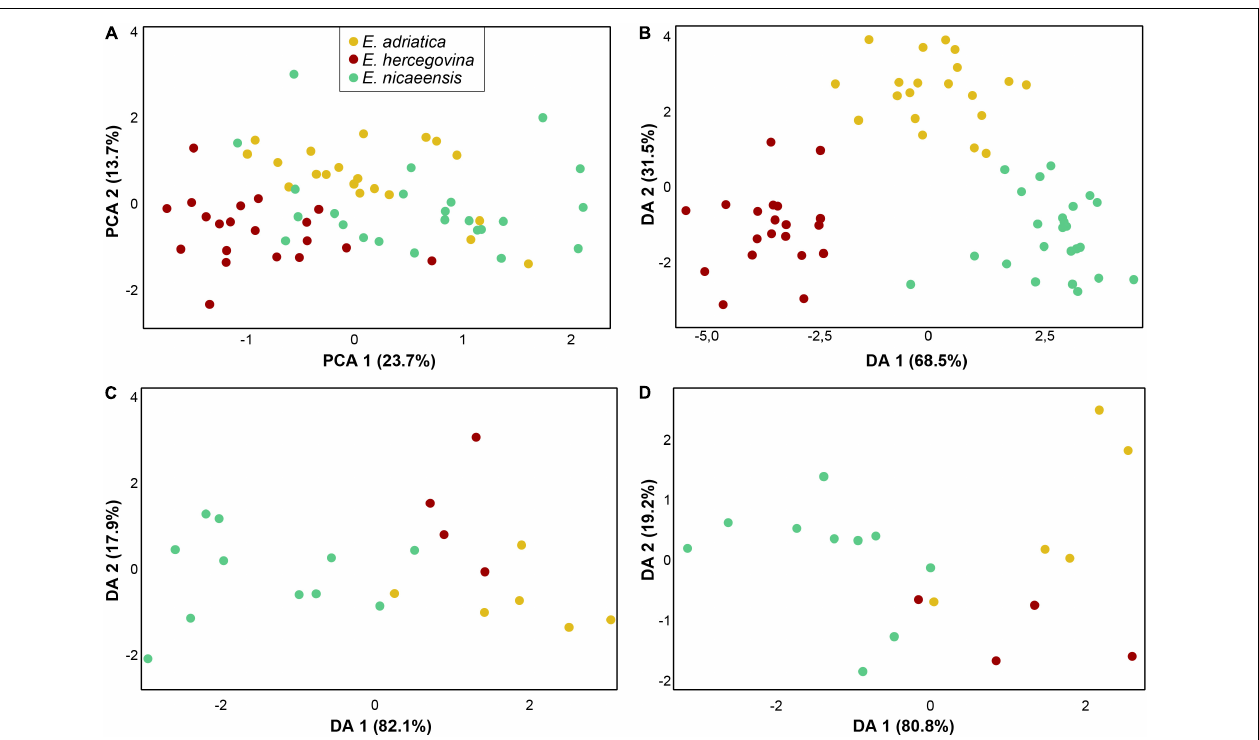
FIGURE 8 | Morphological differentiation amongst Euphorbia adriatica (yellow) , E. hercegovina (red), and E. nicaeensis (green). Principal component analysis (PCA; A ) and discriminant analyses (DA) based on (B) 21 metric and nine ratio vegetative and cyathium characters, (C) five metric and two ratio fruit characters, and (D) six metric and four ratio seed